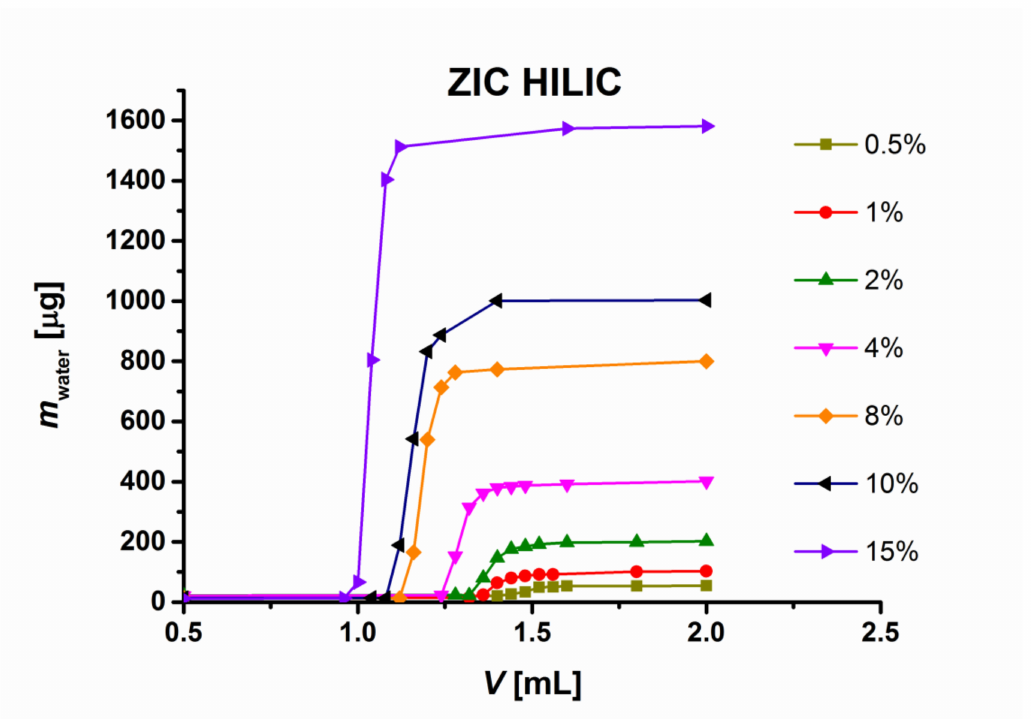
Figure 1. Frontal analysis (breakthrough) plots of water on ZIC HILIC stationary phase at 40 ◦ C. V —volume of the mobile phase; m water —absolute weight of water in 10 µ L fraction of mobile